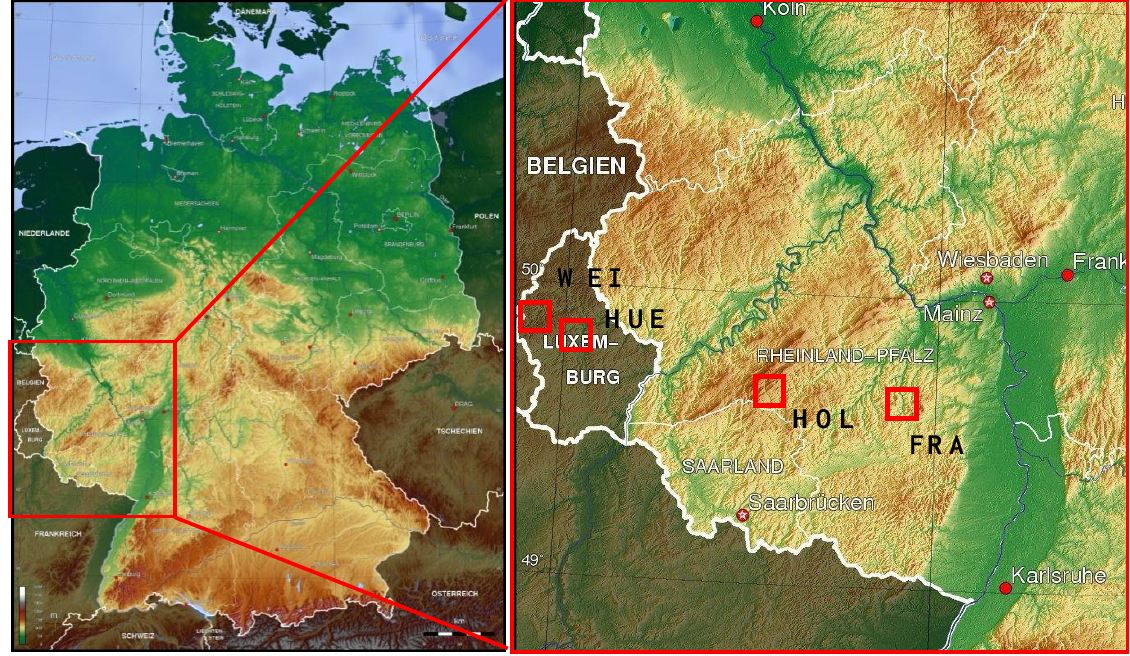
Figure 1. Location of the ForeStClim test sites in Rhineland-Palatinate and Luxemburg (http://www.mygeo.info); FRA = Frankelbach, HOL = Holzbach, HUE = Huewelerbach, WEI =